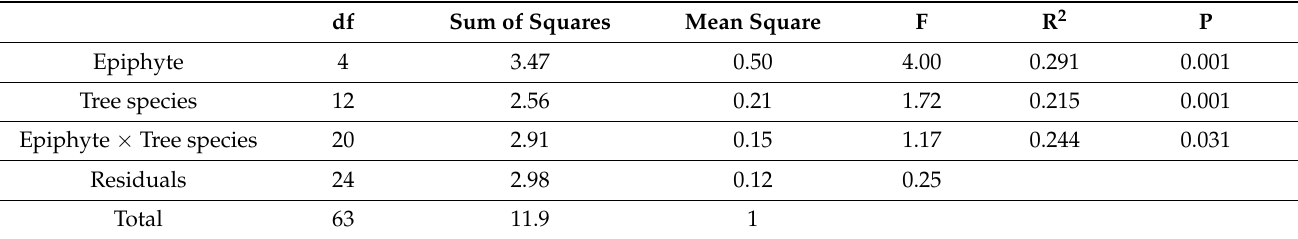
Table 2. Differences in soil metabolome by +/ − epiphyte taxa and tree species ( n = 13). df Sum of Squares Mean Square